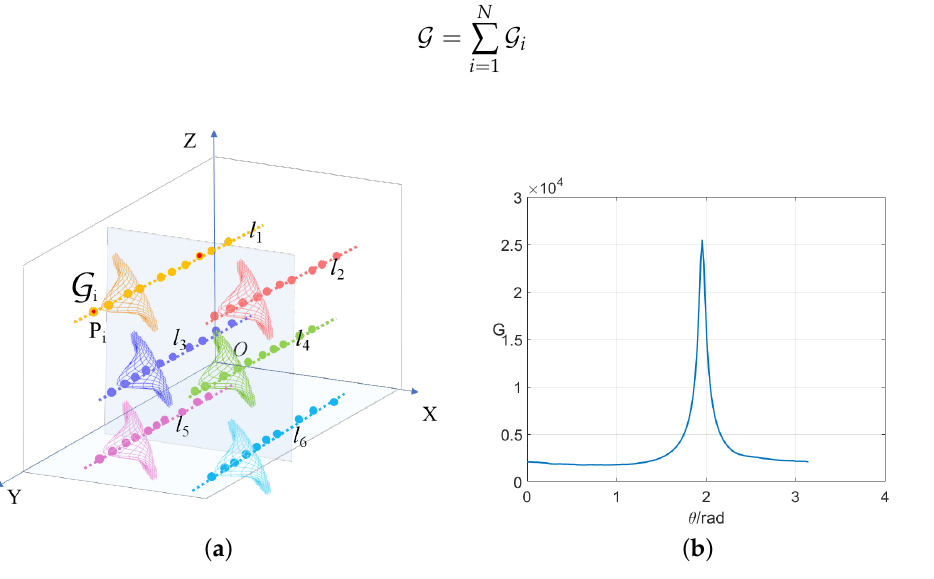
Figure 8. ( a ) The process of spatial line clustering. ( b ) The curve between G and θ